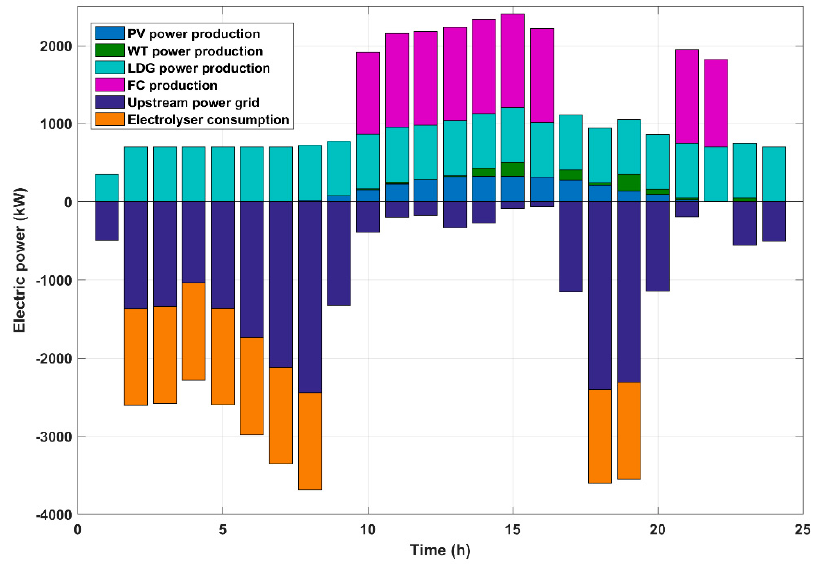
Figure 6. Optimal electric power dispatching results obtained in Case Study 1.